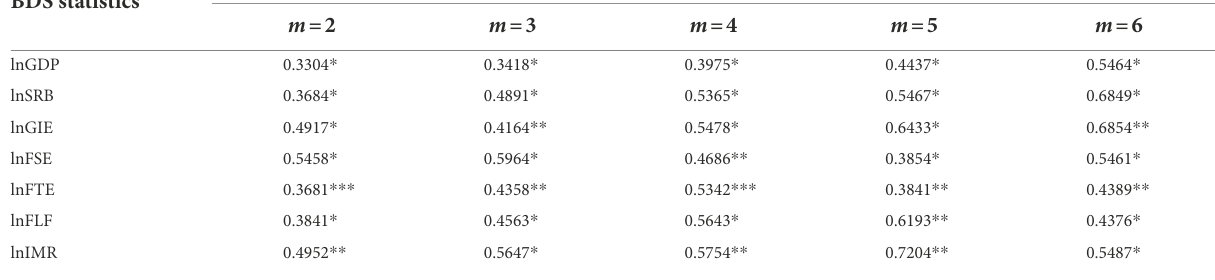
TABLE 3 BDS test for detecting nonlinear